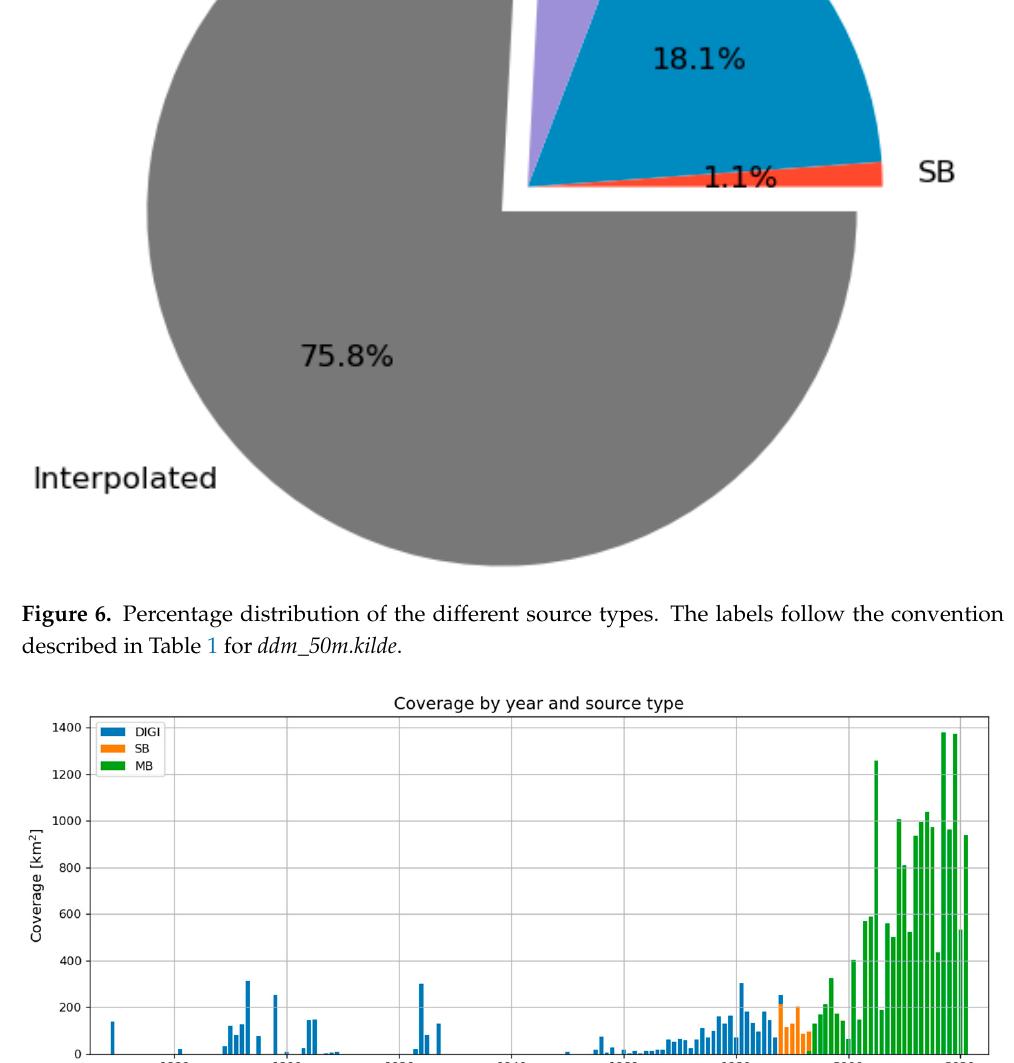
Figure 7. Coverage in km 2 by year and source type. The DDM shows the transition to modern SBES surveys (in orange) in 1988 and the transition to MBES surveys (in green) in 1993.